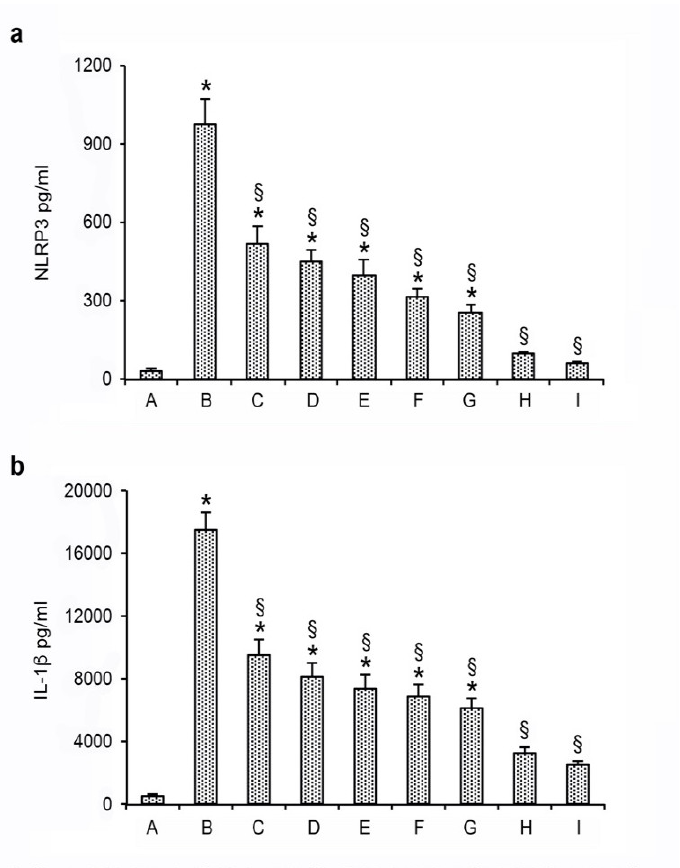
Figure 2. Quantitative evaluation of NLRP3 ( a ) and IL-1 β ( b ) levels in the testes from rats of sham, varicocele, varicocele contralateral, varicocele plus Se (0.4 mg/kg/day i.p.), varicocele plus Se contralateral, varicocele plus PDRN (8 mg/kg/day i.p.), varicocele contralateral plus PDRN, varicocele plus Se plus PDRN, varicocele contralateral plus Se plus PDRN groups. * = p < 0.05 versus sham; § = p < 0.05 versus varicocele. Bars represent the mean ± SE of 7 experiments.